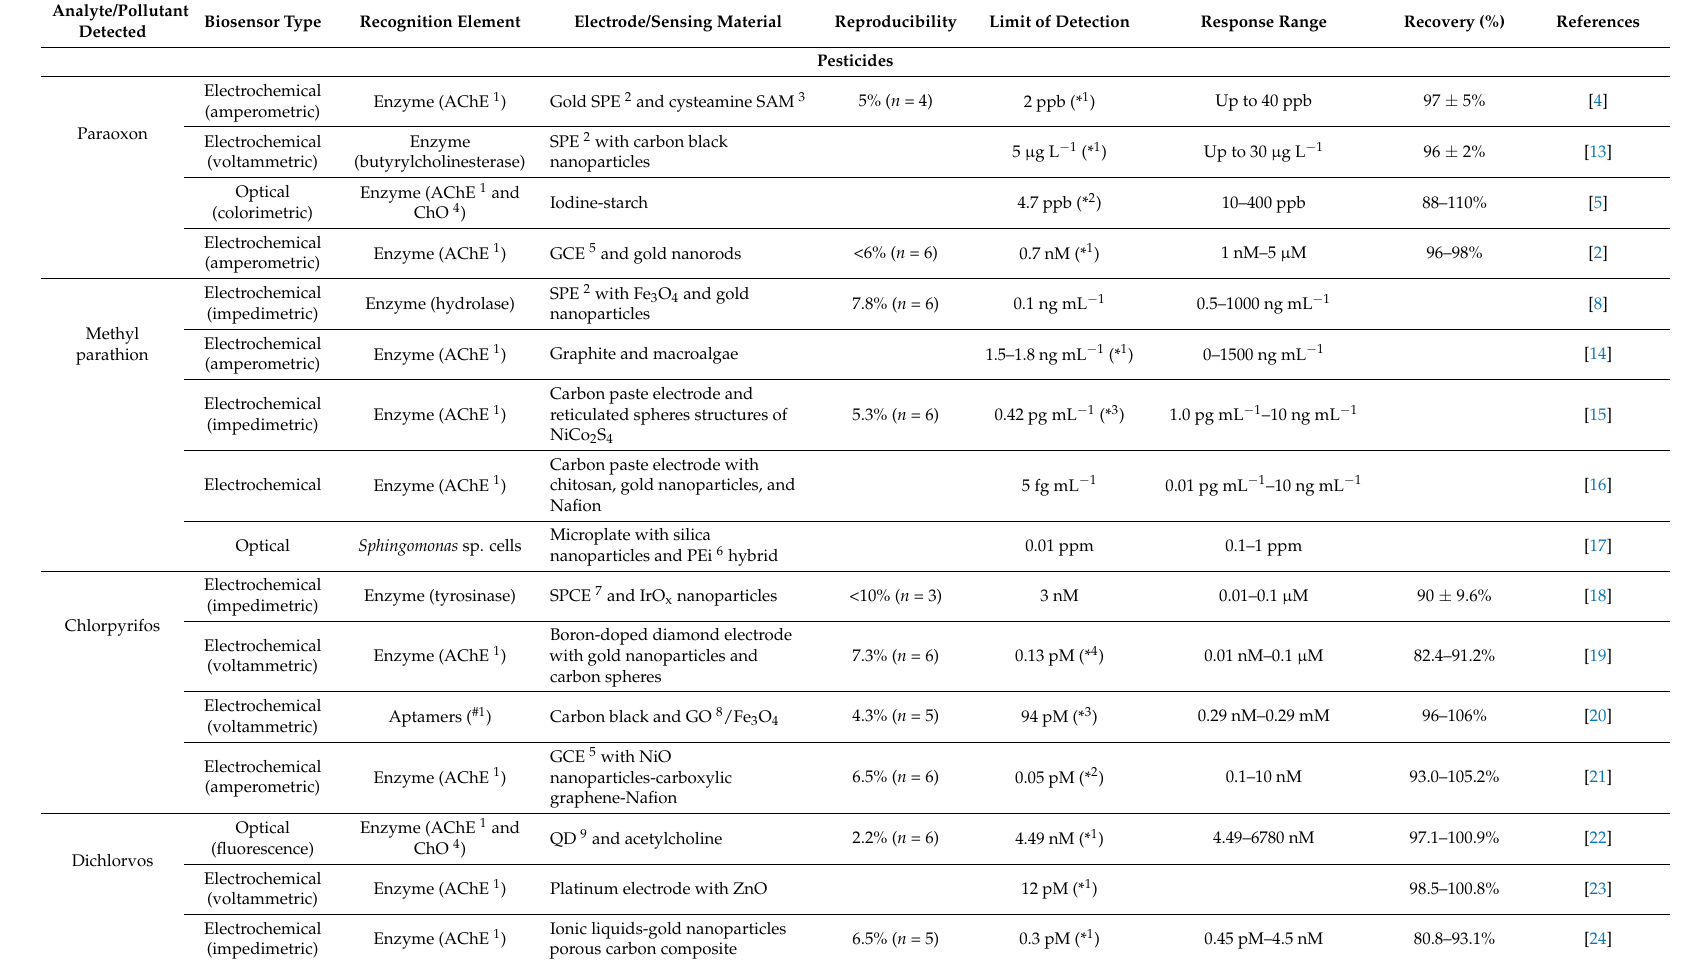
Table 1. Summary of recent biosensors for environmental